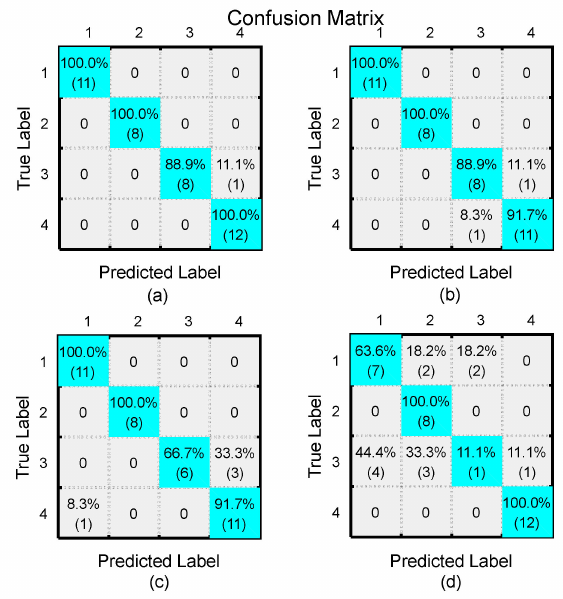
Figure 15. The confusion matrix: ( a ) SymEn; ( b ) ApEn; ( c ) SampEn; ( d )